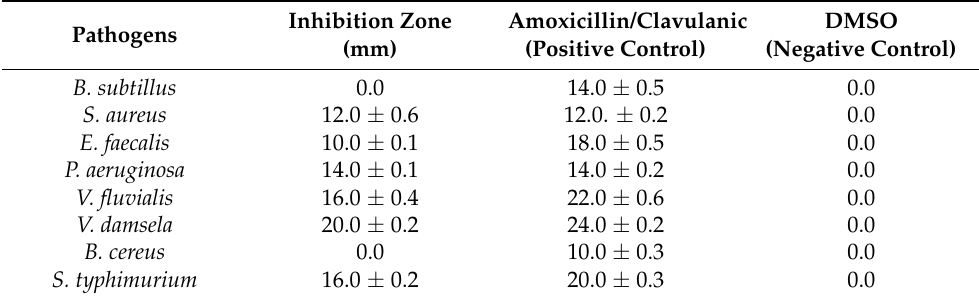
Table 6. Antimicrobial activity of the crude extract of red flower of M. arboreus using well-cut diffusion method.